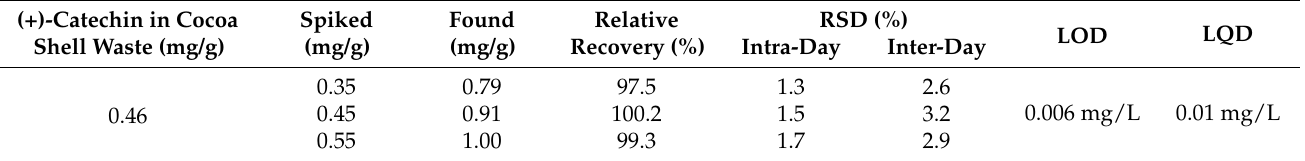
Table 1. Validation results of analysis and SPE process.